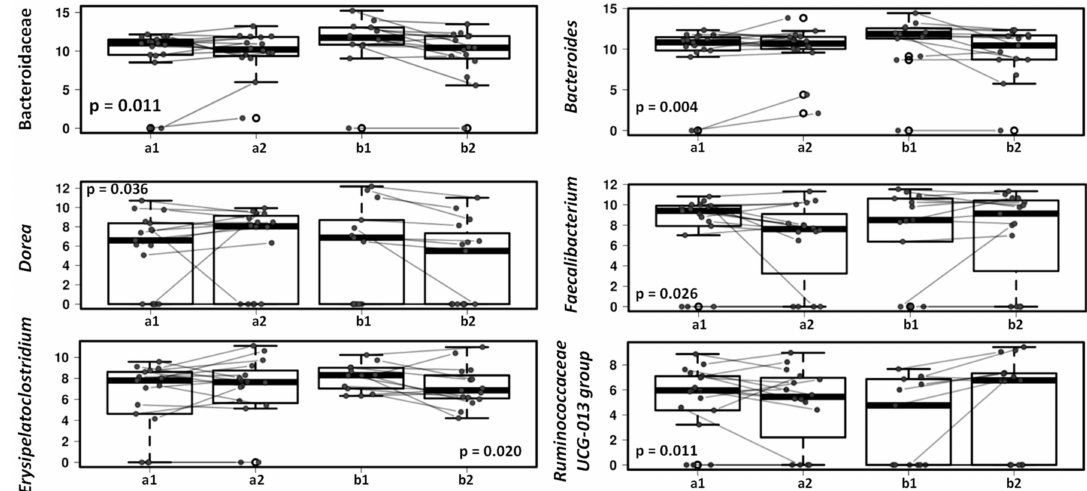
Figure 6. Mixed effect regression models (multilevel models) comparing fecal microbiota in children with dogs receiving placebo (a) and children with dogs receiving lactic acid bacteria preparation (b), before (1) and after 4-weeks intervention